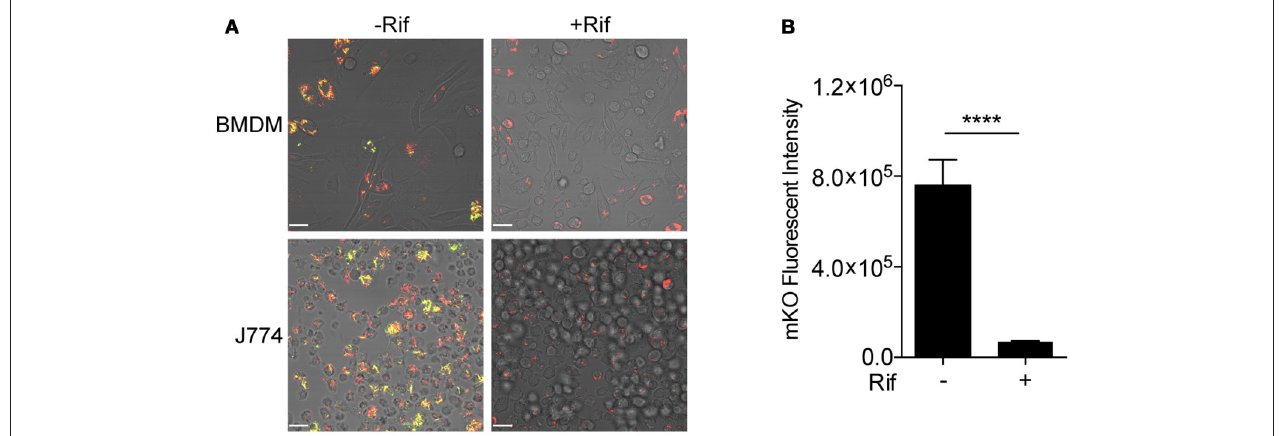
FIGURE 2 | Validation of tet-ON inducible Mtb strain. (A) Confocal images of tet-ON inducible mKO/mCherry infected BMDM (MOI 3) and J774 (MOI 4) cells with or without Rif treatment. Rif (5 µ M) was added to Mtb infected cells 3h post infection. ATc (200ng/ml) was added to cultures on day 4, and confocal images were taken on day 7. (B) The fluorescence signal of mKO was obtained with a plate reader. Data are shown as mean ± standard deviation. The experiments were repeated at least two times. P -value was calculated using Student’s t -test. **** P < 0.0001.